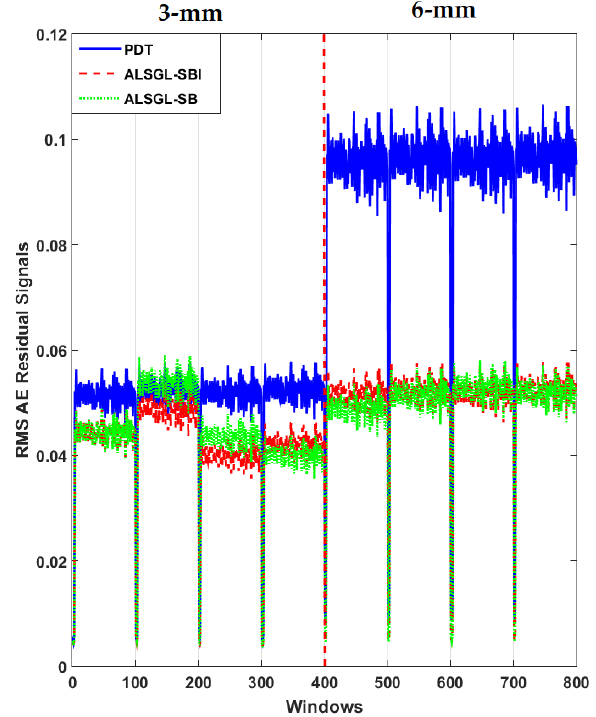
Figure 21. RMS of resampled AE residual signals for crack size (3 mm and 6 mm) diagnosis for outer–ball conditions using ALSGL-SB, ALSGL-SBI and PDT methods.